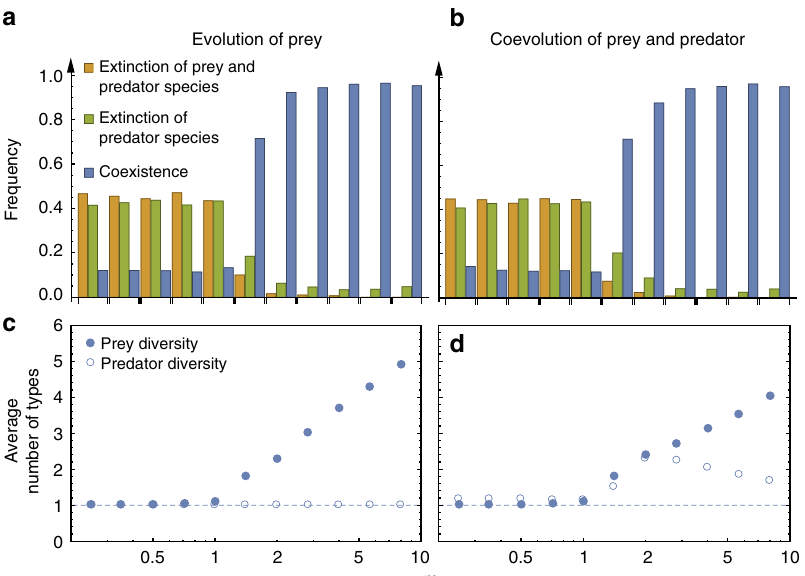
Fig. 5 Intraspeci fi c diversity with predator – prey coevolution and the evolution of only prey species. Under both processes, the prey and predator species are more likely to coexist when m > 1 (a , b) — the predation function is concave and thus defense is effective and cheap. When the prey and predator species coexist, the average number of prey types increases with m under both processes ( c , d) . However, prey species diversity is higher if only the prey species evolves ( fi lled circles in c ) compared to coevolution ( fi lled circles in d ). With coevolution, the predator diversity fi rst increases then decreases with m (open circles in d ). For large m , prey defense is cheap and all predator types evolve to a relatively high predation ability, which decreases the predator diversity (parameter set: b x = 1.0, d x = 0.1, μ x = 0.0001, r c = 0.00005, d y = 0.5, μ y = 0.001, p = 0.005, k max = 0.3, X 1 (0) = 1000, Y 1 (0) = 100, g 1 = 1.0, k 1 = k max , averaged over 1000 independent runs and time period equals to 2000 per each run. Note the values for parameter m in the upper panels correspond to the points in the lower